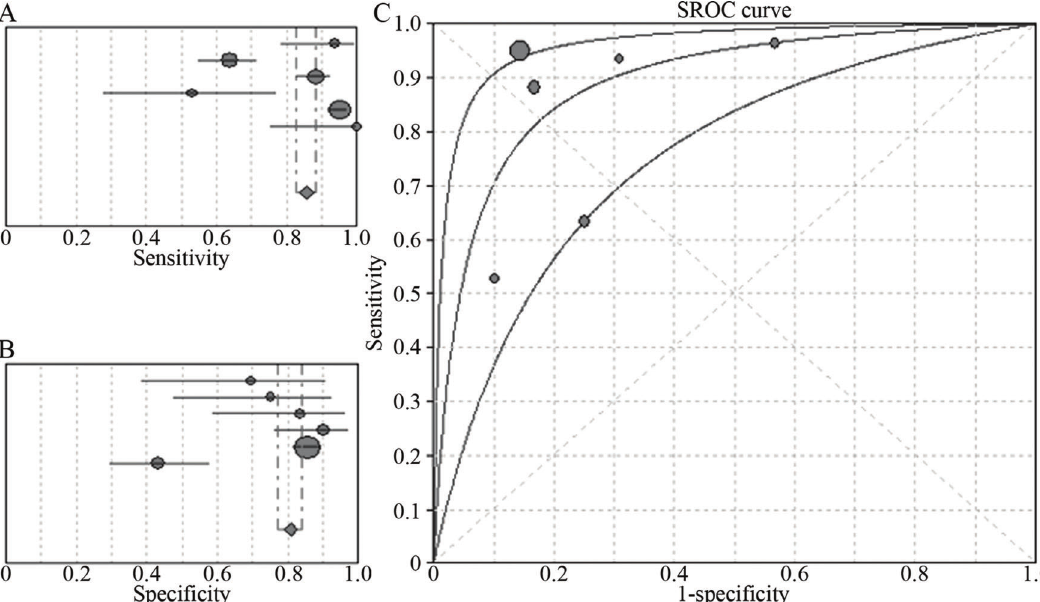
Figure 2 - Six-study analysis of the ability of NBI to diagnose early lung cancer and invasive lung cancer. A. Pooled sensitivity of NBI for the diagnosis of early lung cancer and invasive lung cancer; B. Pooled specificity of NBI for the diagnosis of early lung cancer and invasive lung cancer; C. The summary receiver operating characteristic (SROC) curve for the diagnosis of early lung cancer and invasive lung cancer by NBI.